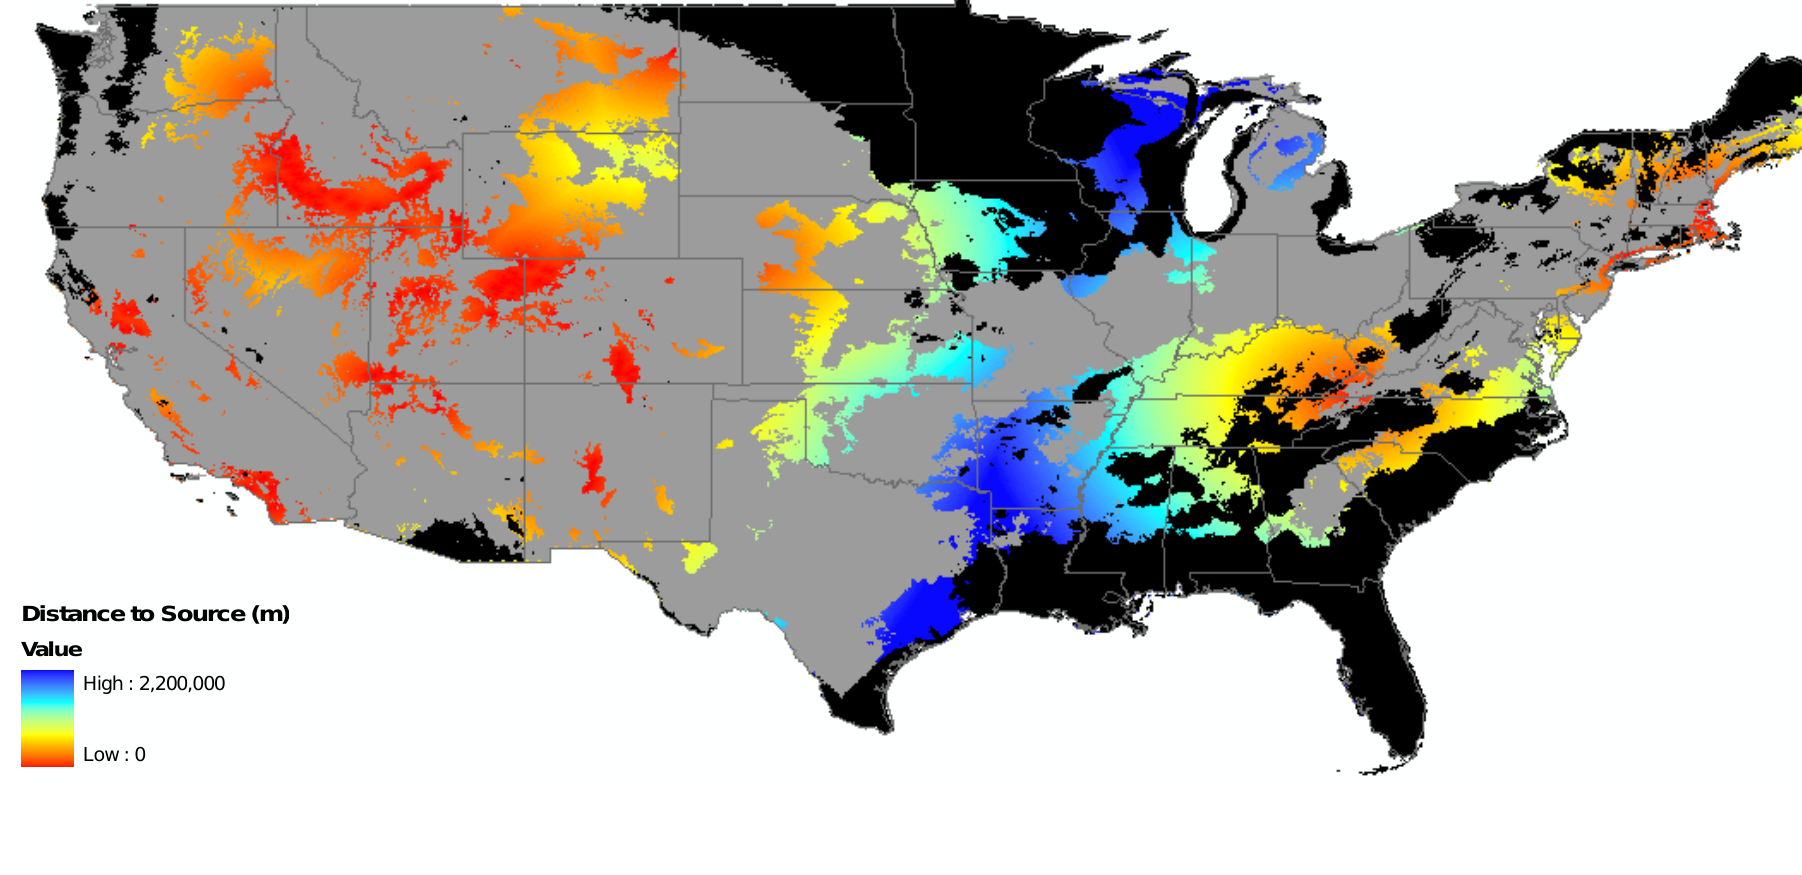
Figure 1. Invasibility Index. Colors on the red end of the spectrum are closer to known seed sources, colors on the blue end of the spectrum are farther away. Grey represents unsuitable habitat, black represents areas of clamping, or where the model was extended beyond the environmental space it was trained